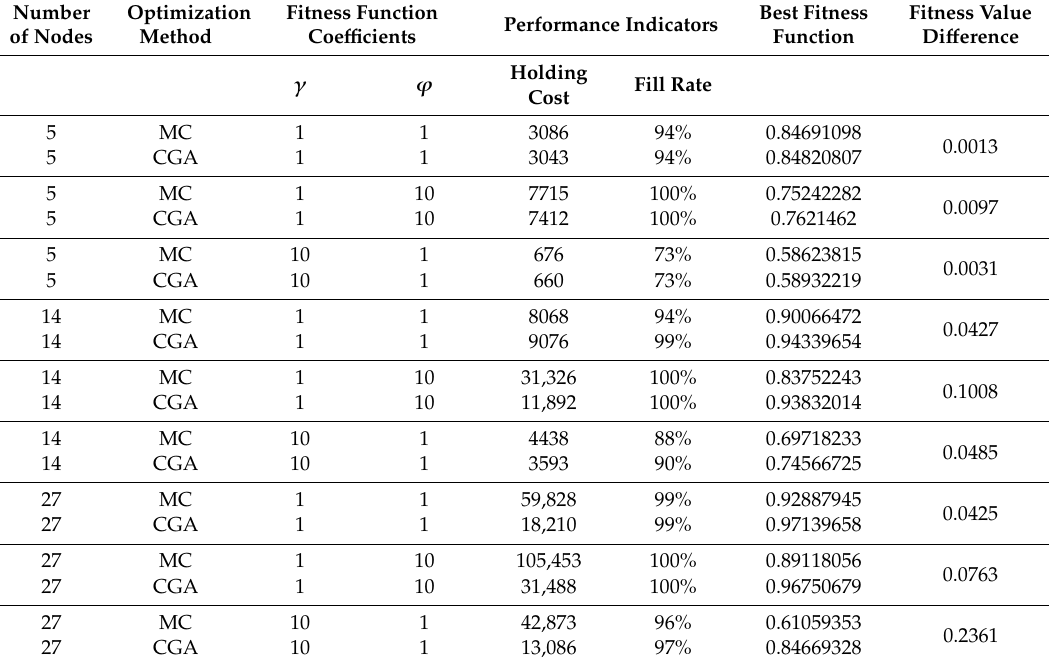
Table 7. Detailed results of the Monte Carlo (MC) method vs. the